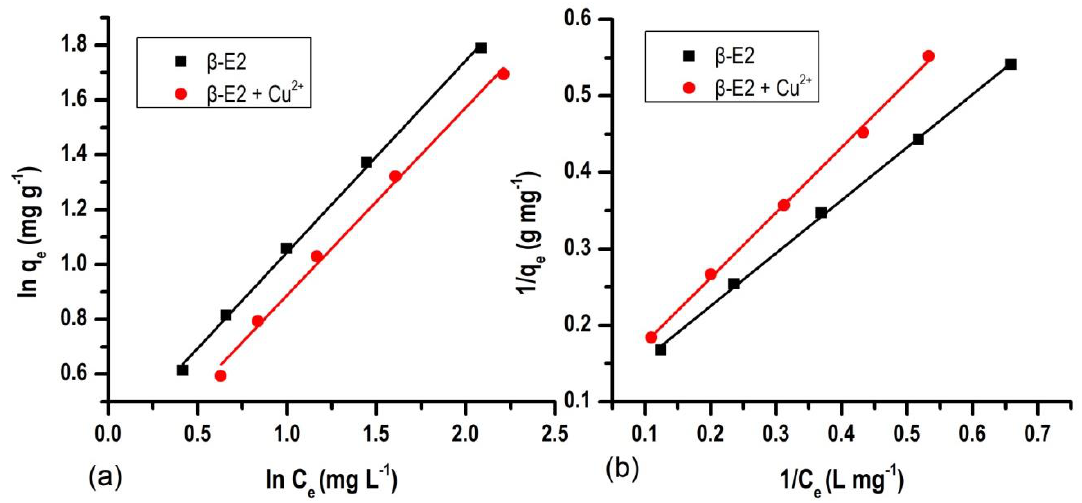
Figure 5. Isotherm plots for 17β-E2 adsorption by sand in different solutions ( a ) Freundlich fit and ( b ) Langmuir fit.